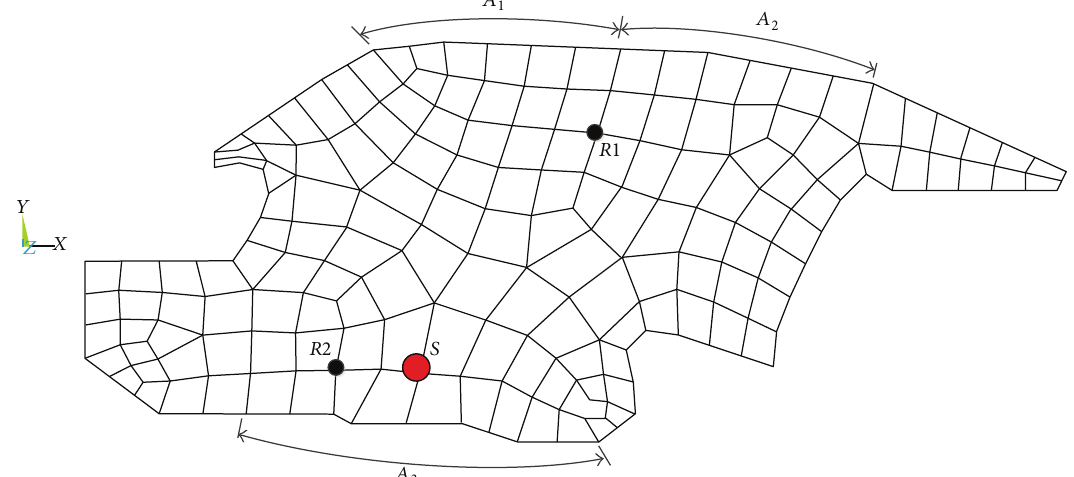
Figure 10: Finite element mesh of the 2D car cavity.